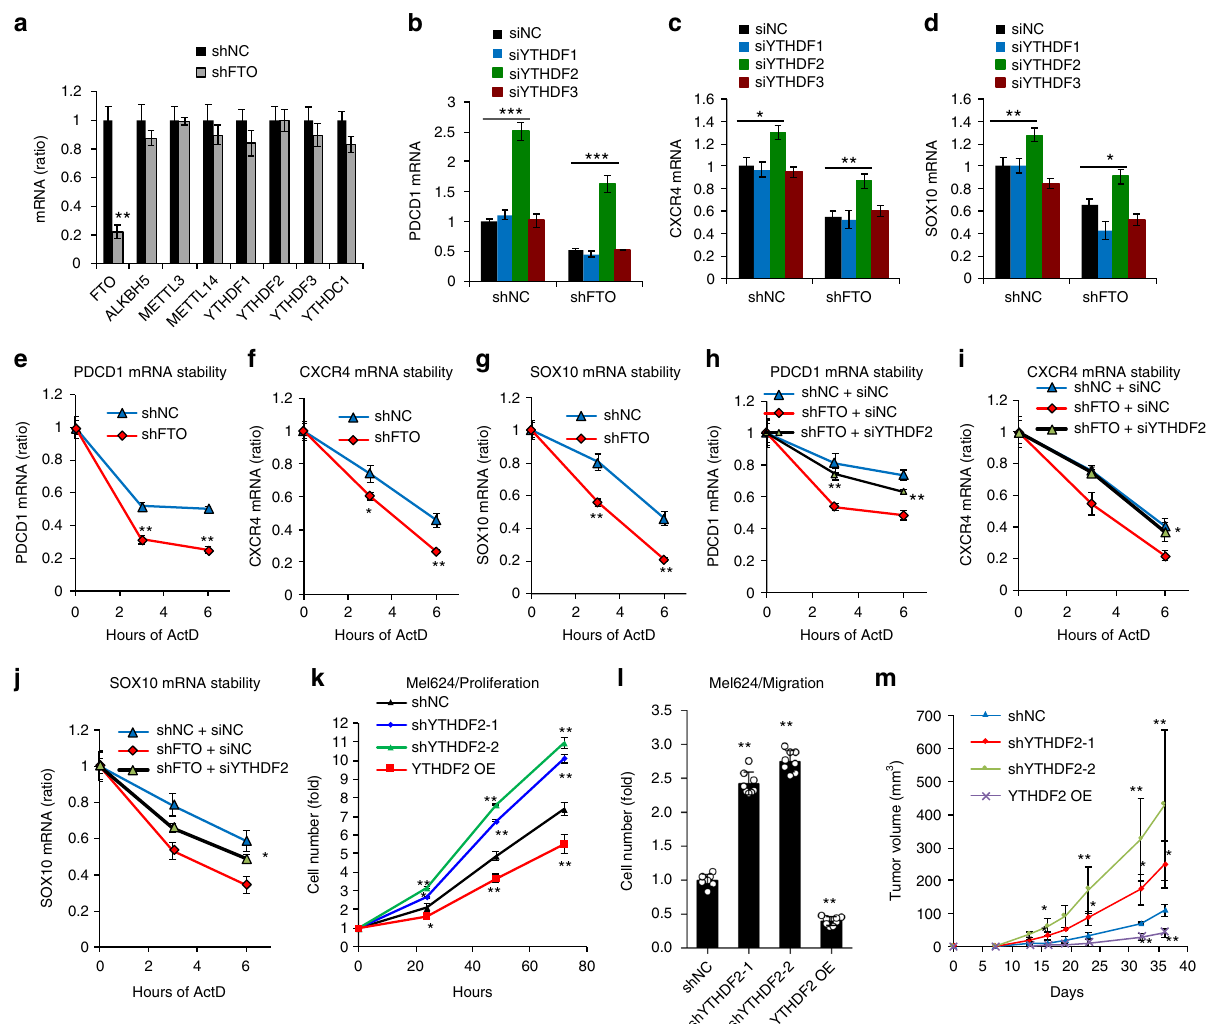
Fig. 6 FTO regulates its target gene expression through suppressing m 6 A/YTHDF2-mediated mRNA decay. a qPCR analysis of mRNA levels in Mel624 stable cells of shNC or shFTO. b – d qPCR analysis of the mRNA levels of PD-1 (PDCD1) ( b ), CXCR4 ( c ), and SOX10 ( d ) in Mel624 cells with or without FTO knockdown, in combination with siRNA knockdown of the m 6 A readers YTHDF1-3. e – g qPCR analysis of the mRNA stability of PD-1 (PDCD1) ( e ), CXCR4 ( f ), and SOX10 ( g ) in Mel624 cells with or without FTO knockdown. h-j qPCR analysis of the mRNA stability of PD-1 (PDCD1) ( h ), CXCR4 ( i ), and SOX10 ( j ) in Mel624 cells with or without FTO knockdown in combination with or without siRNA knockdown of YTHDF2. k , l Cell proliferation ( k ) and migration ( l ) analysis in Mel624 with or without knockdown or forced overexpression of YTHDF2. m Tumor growth of Mel624 cells with or without knockdown or forced overexpression of YTHDF2 after subcutaneous injection in nude mice ( n = 3). Data are shown as mean ± S.E. ( a – k ), or mean ± S.D. ( l and m ) ( n ≥ 3). * P < 0.05; ** P < 0.01; Student ’ s t